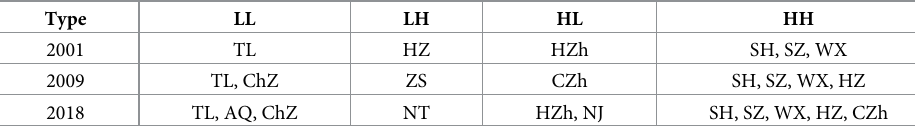
Table 3. The LISA clustering of HDCT.